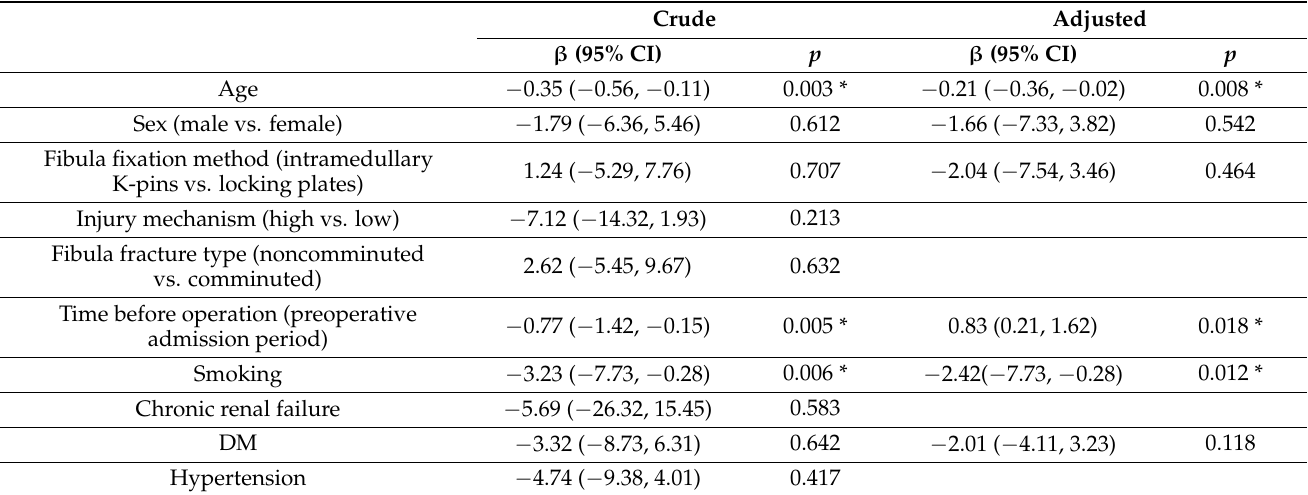
Table 4. Factors associated with better OMAS among all patients ( n =